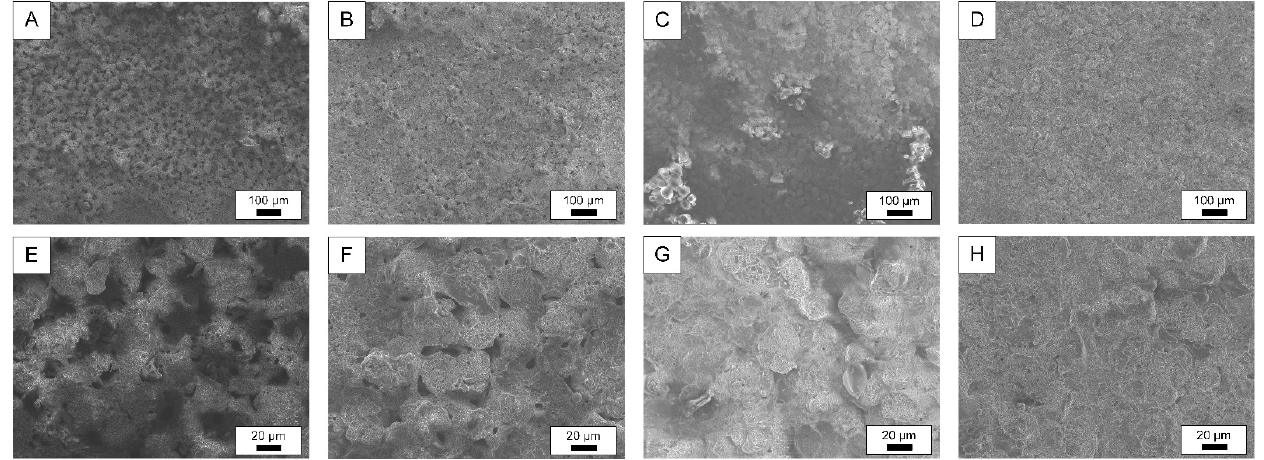
Figure 3. SEM images of the surface morphology of different MAO-coated samples: 0GO ( A , E ), 0.1GO ( B , F ), 0.3GO ( C , G ), 0.5GO ( D , H ).